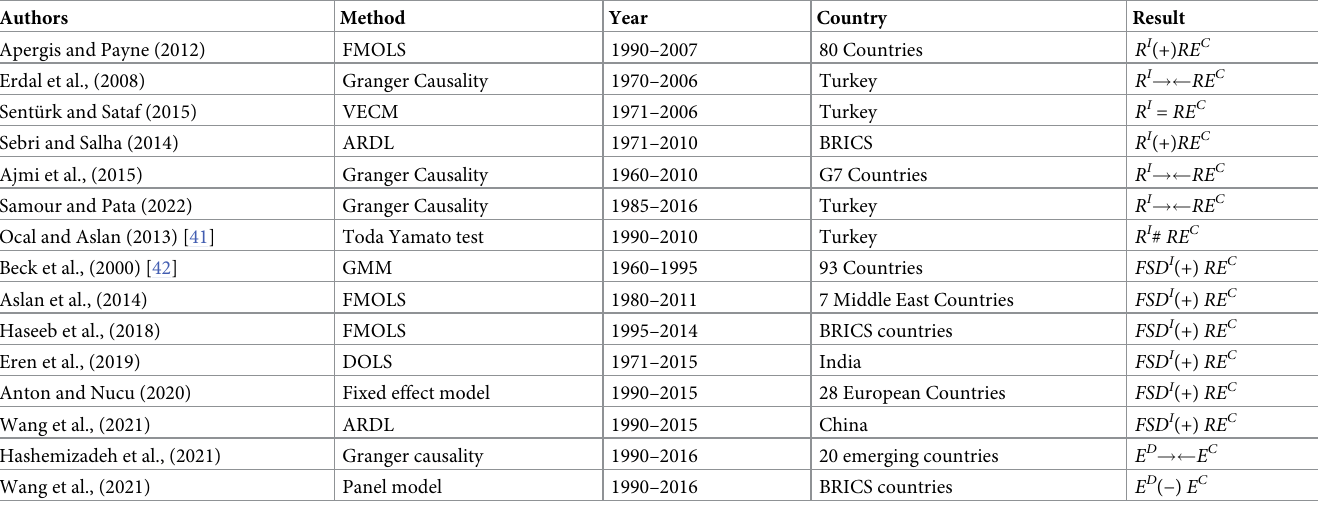
Table 1. Summary of literature of